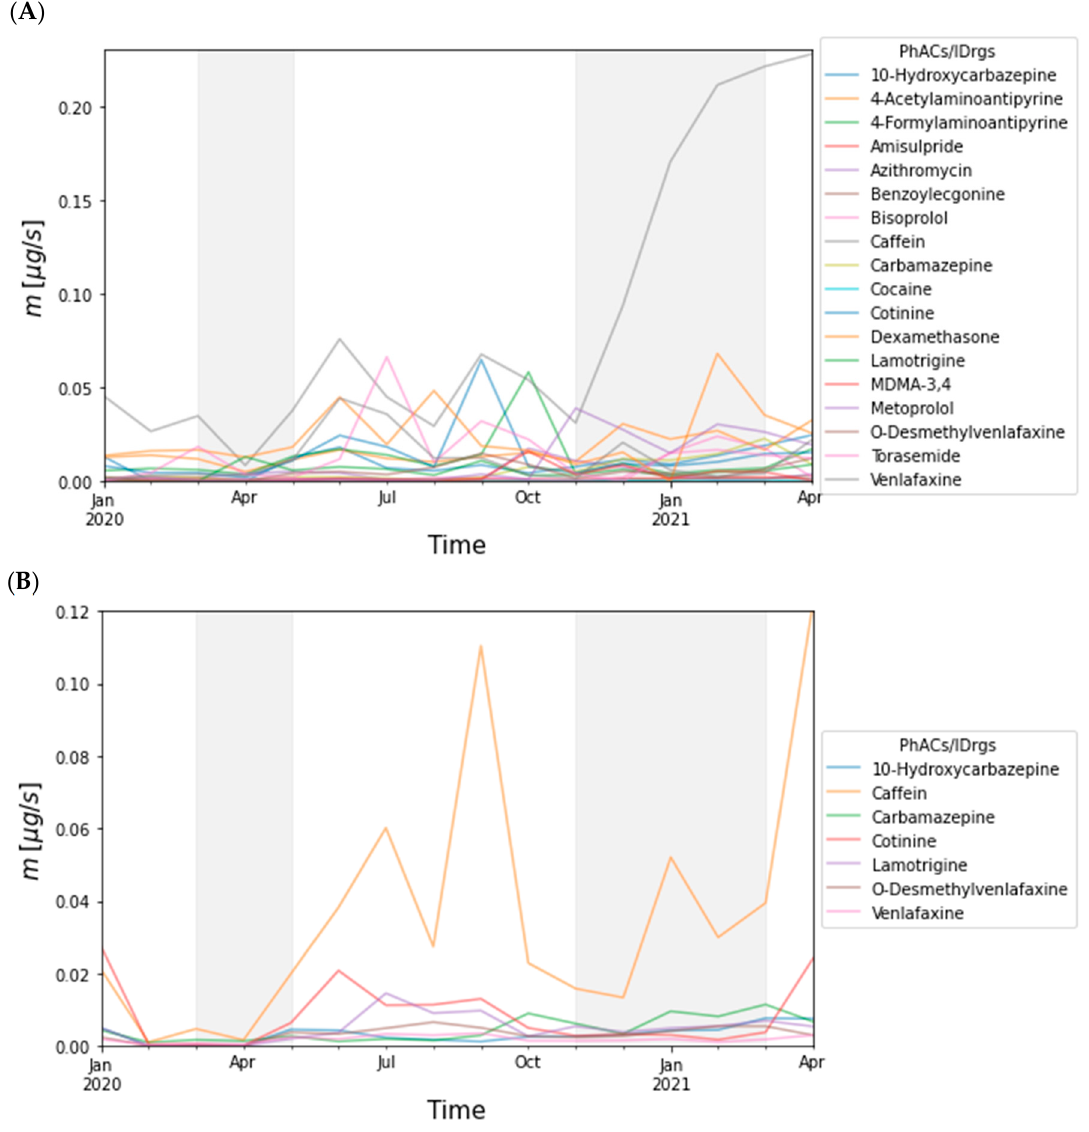
Figure 3. Average mass flow ( µ g/s) of all measured PhACs/IDrgs across all sites in the rivers during 16 months: ( A ) Sava and ( B ) Drava. Time periods for the first and the second lockdown are marked in grey.